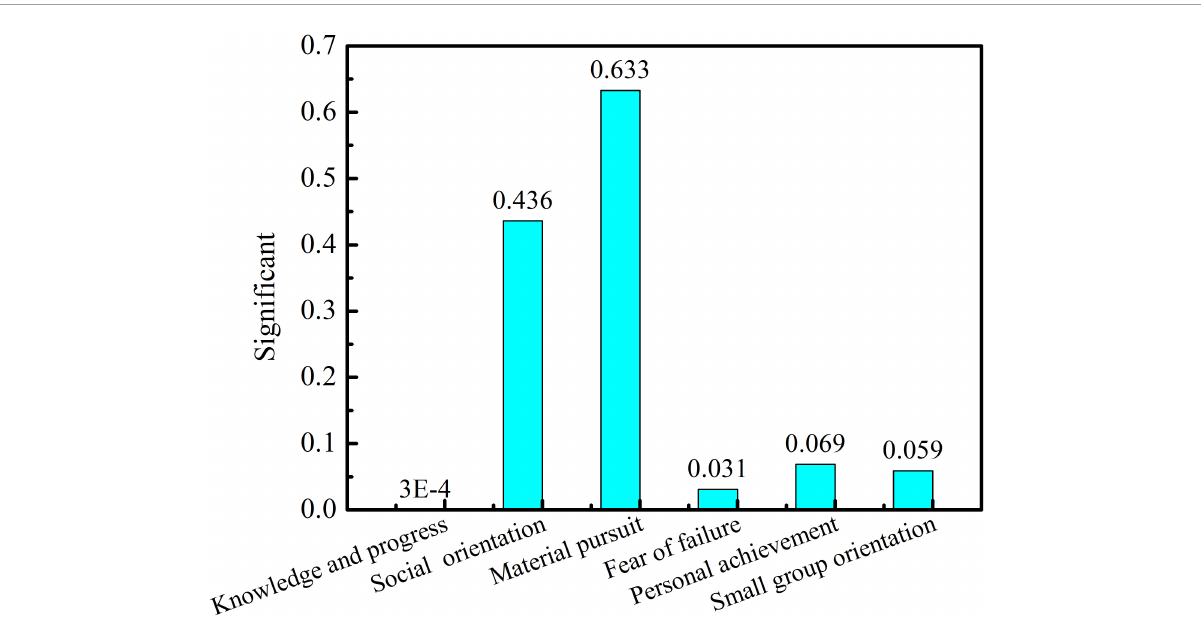
FIGURE2 Significance of students’ learning motivation in college of metallurgical engineering, college of mechanical and electrical engineering, and architecture college of Xi’an.